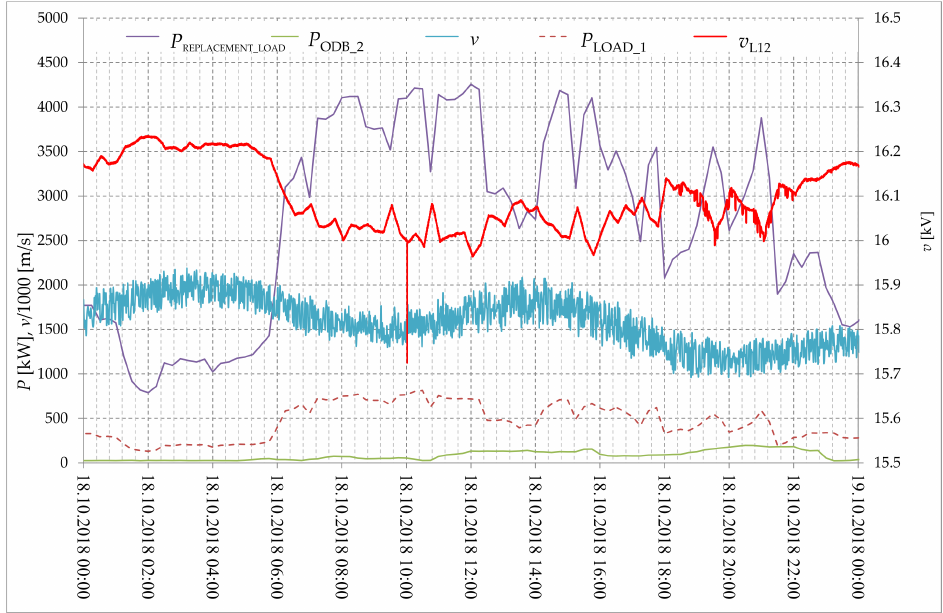
Figure 20. Waveforms of variation of the e ff ective value of phase-to-phase voltage (L1-L2) in PCC from 18 October 2018, including active load power profiles and wind speed